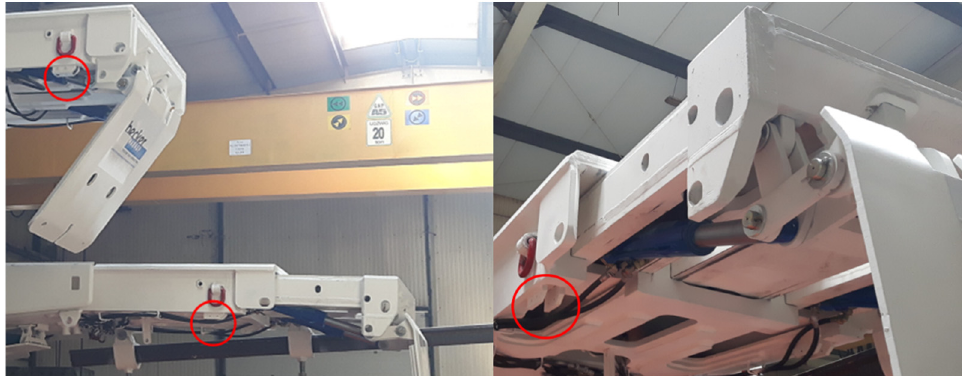
Figure 3. The BW 24/44 POz shield support with marked space for the SSMS-S sensor. The end part of the canopy is extendable while the sensor is installed at the end of its fixed part. This makes an additional problem in terms of correct sensor readings. The sensor may misinterpret waves reflected from the transverse surfaces of components lo- cated at the end of the canopy as echo reflected from the longwall face. Figure 4 shows a view from the sensor’s installation place. There is only a small space through which the waves will propagate towards the longwall face and back after reflection from it. The mobility of the end part of the canopy makes it impossible to extend the sensor’s dead zone beyond the range of its components, which would solve the problem of interference in the form of waves reflected from those components.